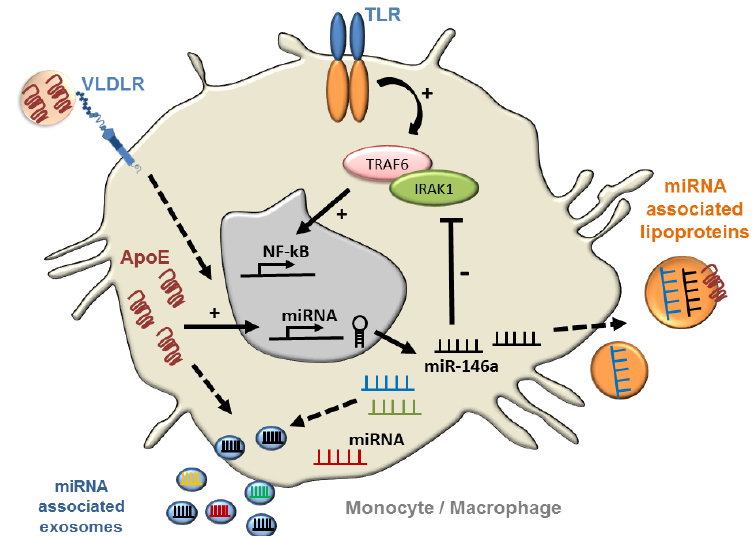
Figure 4. ApoE regulation of NF- κ B signaling in monocytes and macrophages via microRNA. ApoE